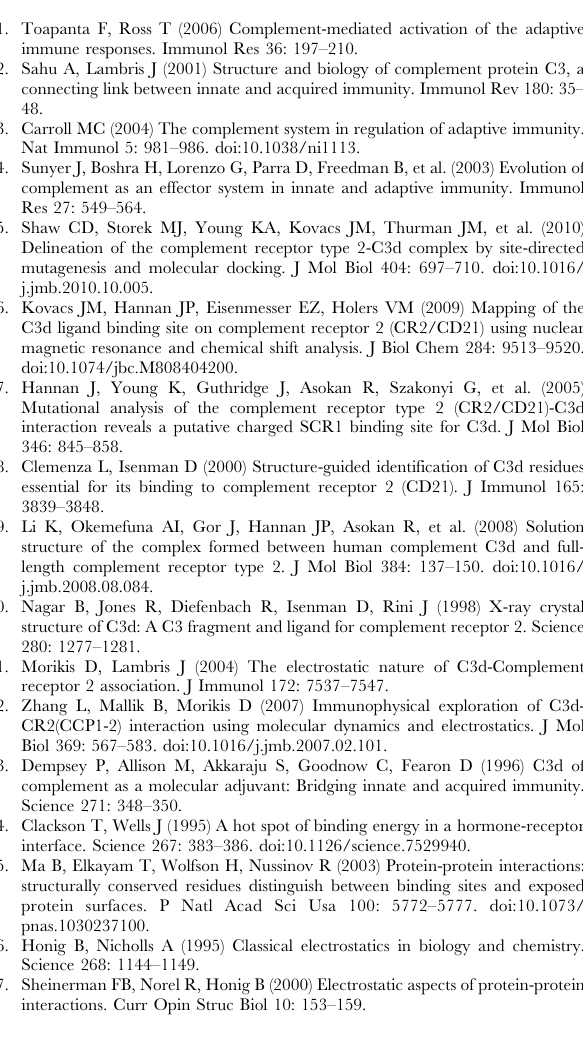
includes residues that contain at least one atom with an x- coordinate . (mean(x) + 5 A˚ ). Table S1 List of complement C3d homologues with UniProt accession ID, human C3d percent identity, and net charge. (TIFF) Text S1 Details of homology modeling and molecular dynamics